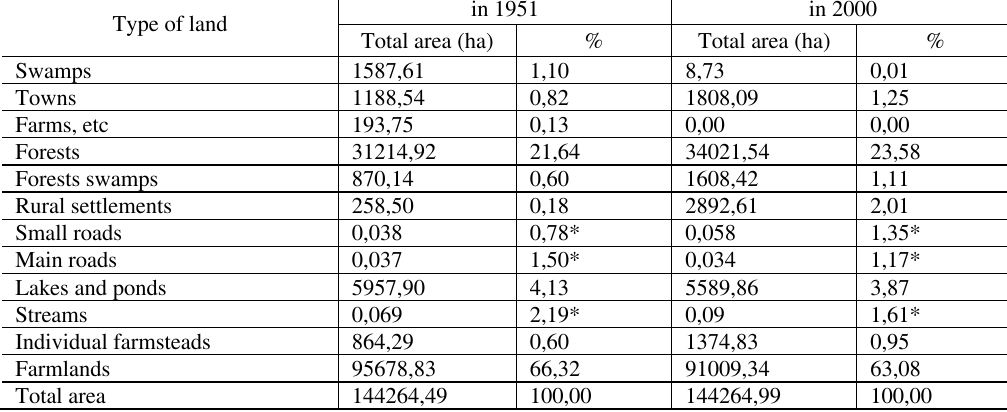
Table 1. Change dynamics of landscape cover structure in reference area of hilly morainic relief